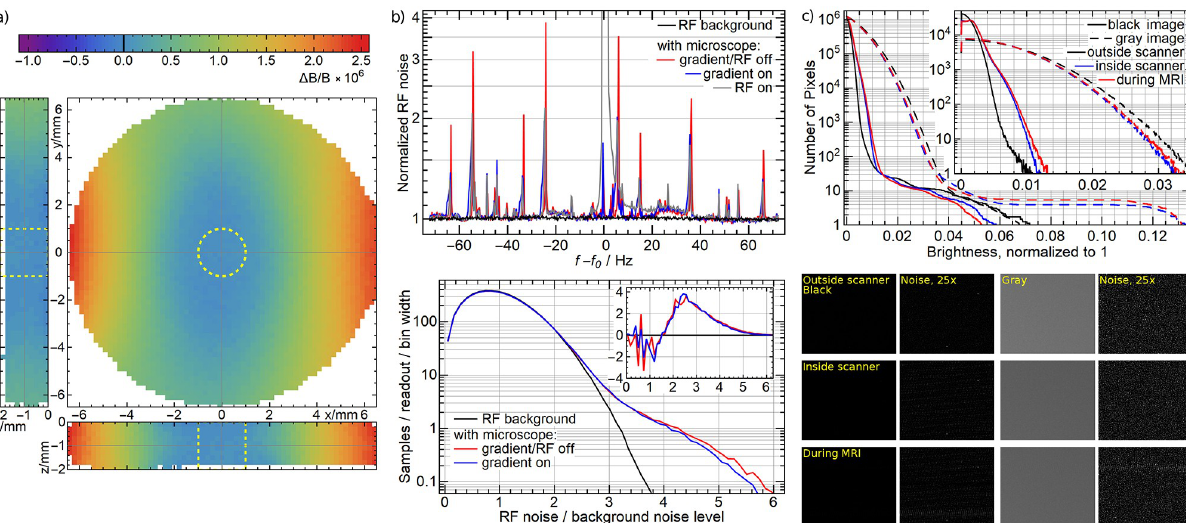
Fig 6. a) Distortion of the magnetic field in a 2mm thick 13mm diameter agarose phantom: Planes through the center of the maximum sample volume (dashed yellow lines), normalized to 0 at the center. Data points without signal inside the sample volume are extrapolated. Worst-case using a RF volume coil enclosing the microscope: b) Magnitude of the MR noise normalized to the average of the background noise (top) without the microscope and with the microscope, without RF and gradient fields, with the gradients turned on and with RF excitation in the presence of a small agarose phantom. Histogram of the magnitude of the MR noise (bottom), normalized such that the integral corresponds to the samples per readout; inset: difference to the background noise. c) Integrated histogram of the optical noise (main graph), histogram of the optical noise (inset) of a black image and a gray image outside of the MR scanner, inside the MR scanner (in the B 0 field) and during the MR measurement. Optical sample images (segments of 143 × 121 pixels) and the magnitude of their optical noise scaled by